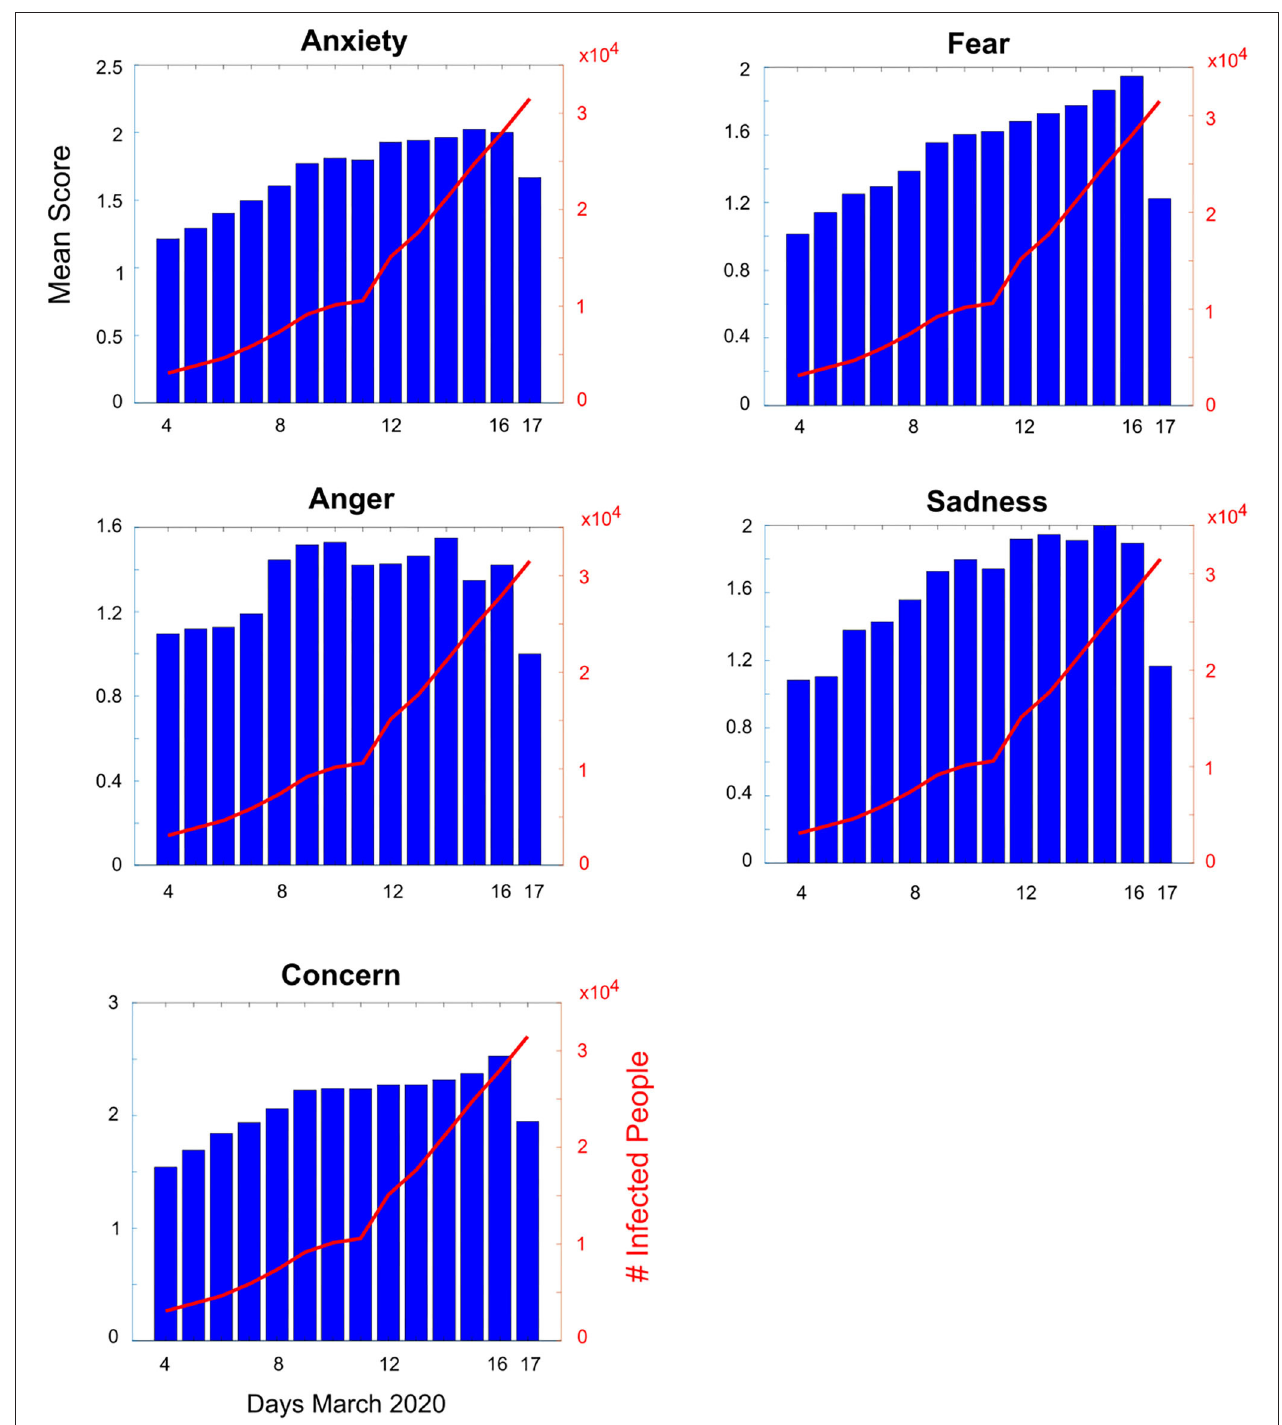
FIGURE 2 | Correlation between the perceived psychological impact and increase in the number of COVID-19 cases (from 4 to 18 March 2020). Blue bars represent the mean score for psychological impact (anxiety, fear, anger, sadness, concern) per day. Red axis shows the increasing number of infected people during the same